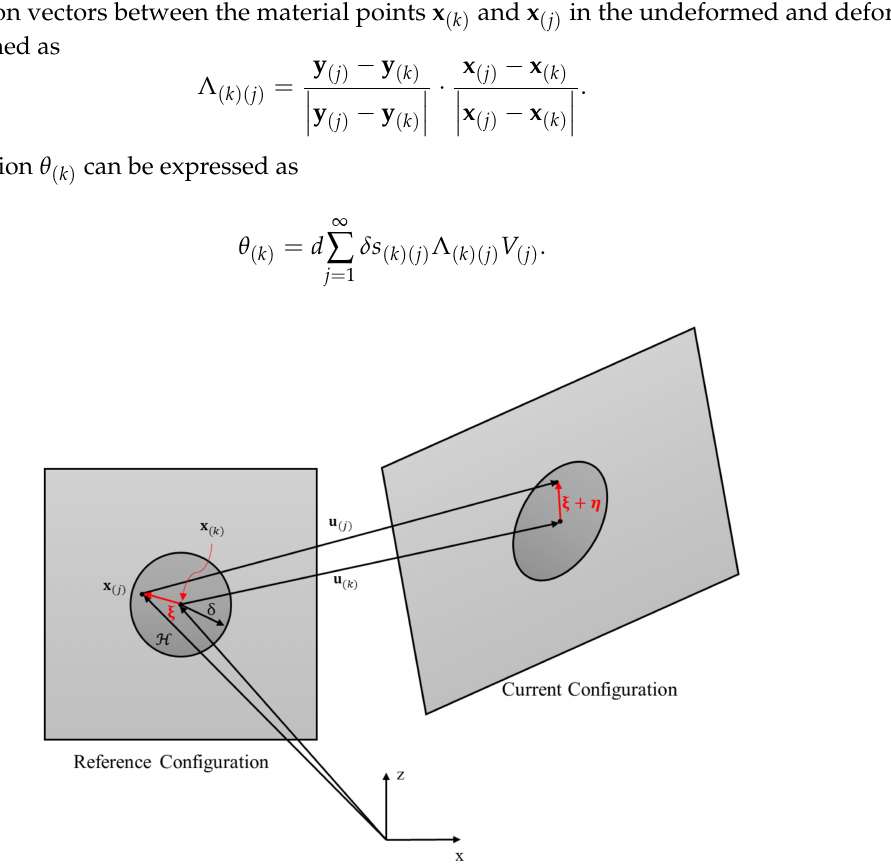
Figure 1. Peridynamic model